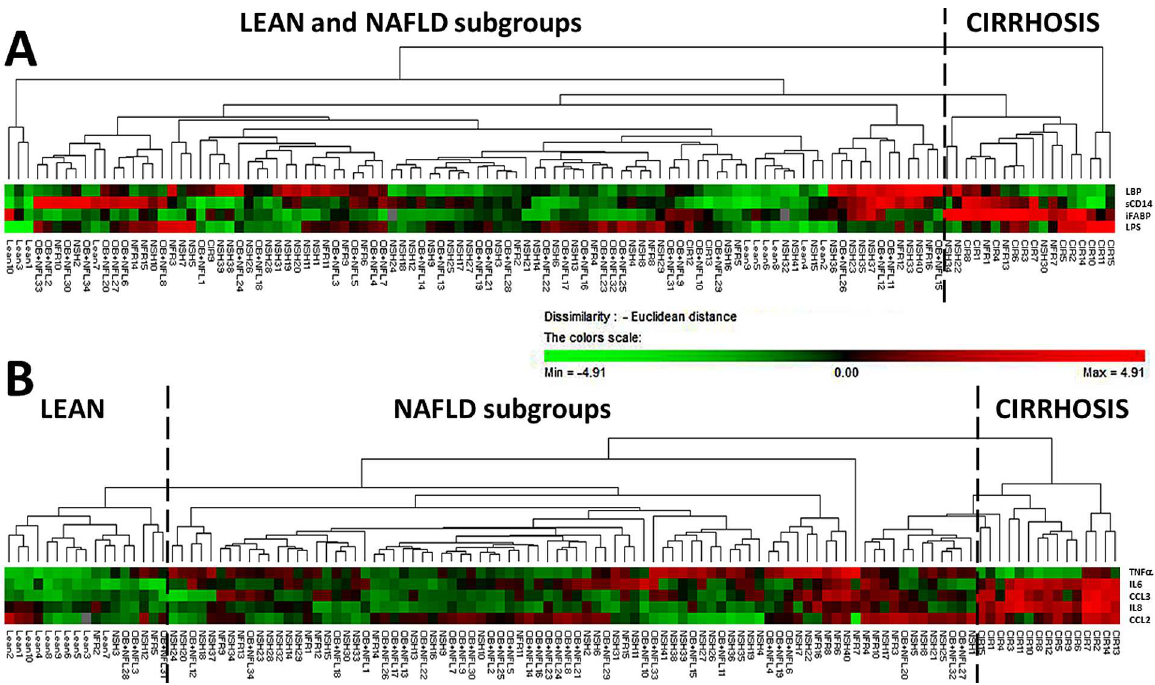
Fig 3. Hierarchic clustering was performed of patients using plasma levels of cytokines, chemokines and markersof endotoxemia to investigate global distribution along the 5 histological subgroups. Fig 3A. Hierarchic cluster analysiswas performed using iFABP, LBP, LPS and sCD14. Using these markers only a group enrichedwith cirrhotic patients could be distinguished from the rest. In Fig 3B we used clusteringon 5 cytokine/inflammation markers (CCL2, CCL3, TNF α , IL6 and IL8), whereby3 blocks could be distinguished with some patients misclassified, using the same statistical setting (Euclidiandistance, McQuitty’s linkagerule and normalized Z-score, see [22]). Abbreviations: CIR: cirrhosis; OB: obese with no NAFL; NFL: NAFL; NFR: NASH with fibrosis and NSH: NASH.